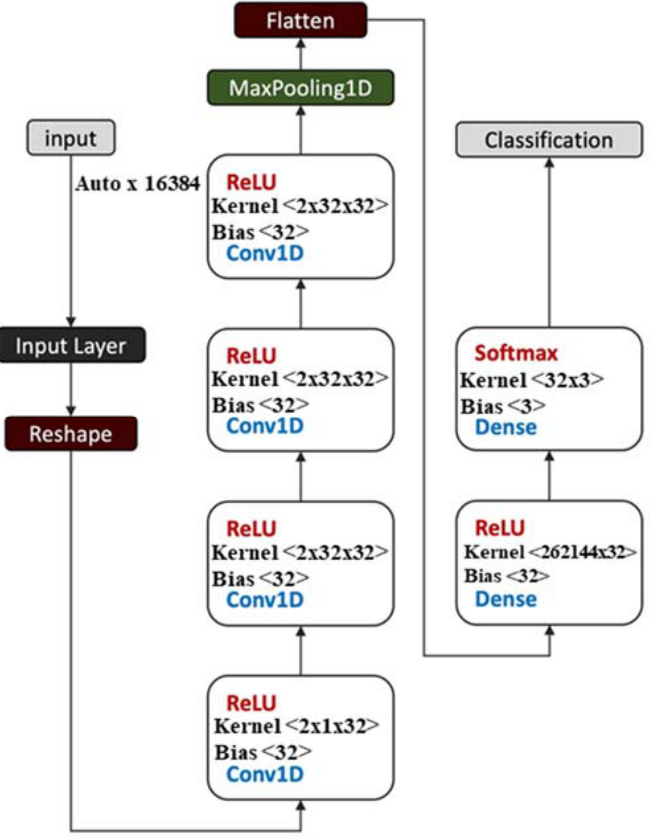
Figure 5. Convolutional neural network (CNN) architecture including input layer, convolution layers, pooling layer, output layer, and classification (Conv1D = Conversion 1D).